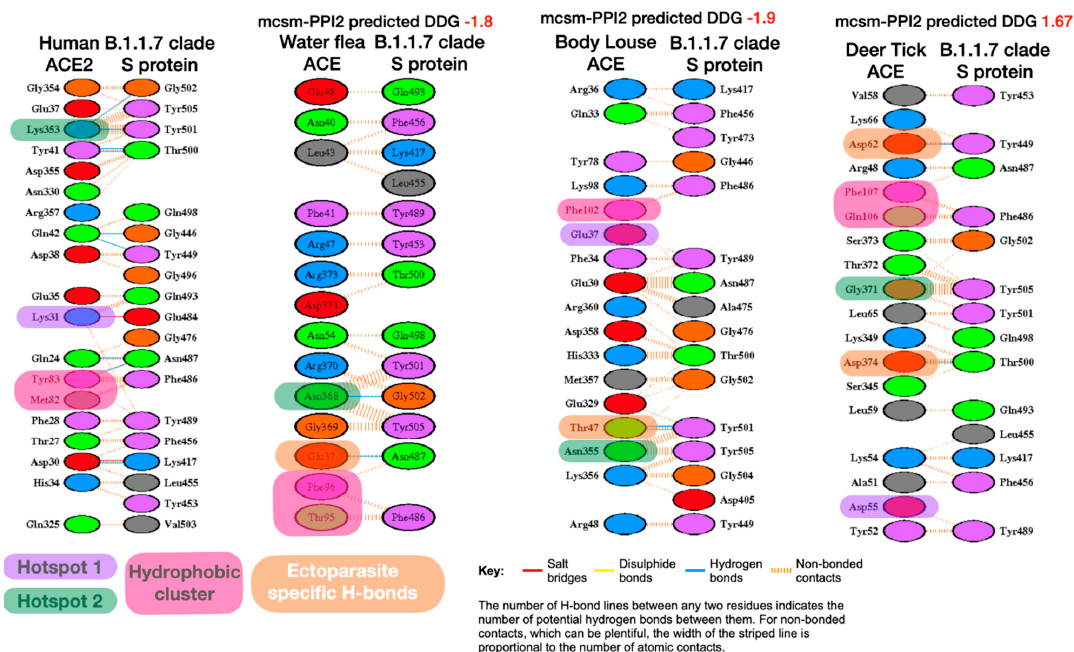
Figure 3. Comparison of LigPlot predicted bonding interactions for B.1.1.7 clade with human, water flea, body louse and deer tick. Corresponding residues in each species with key human interface hotspots (Hotspot 1, Hotspot 2) and the hydrophobic pocket are indicated if they are predicted to be involved in interface interactions. Novel ectoparasite H-bond residues also shown (orange boxes). In body louse, the ectoparasite-specific H-bond between Thr47 and Tyr501 is indicated as an equivalent to the important ‘Hotspot 2’ found in human spike:ACE2 interface.